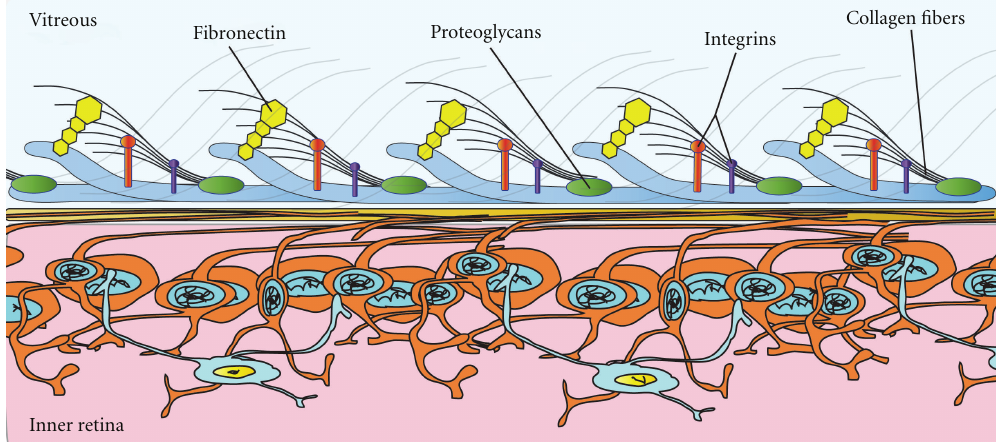
Figure 1: Illustration of the vitreoretinal attachments at the vitreoretinal interface. The posterior vitreous cortex is attached to the ILM by collagen fibers at the vitreoretinal interface. These fibers fuse with the ILM and along with macromolecules, such as laminin, fibronectin, and chondroitin anchor the vitreous cortex to the retina.